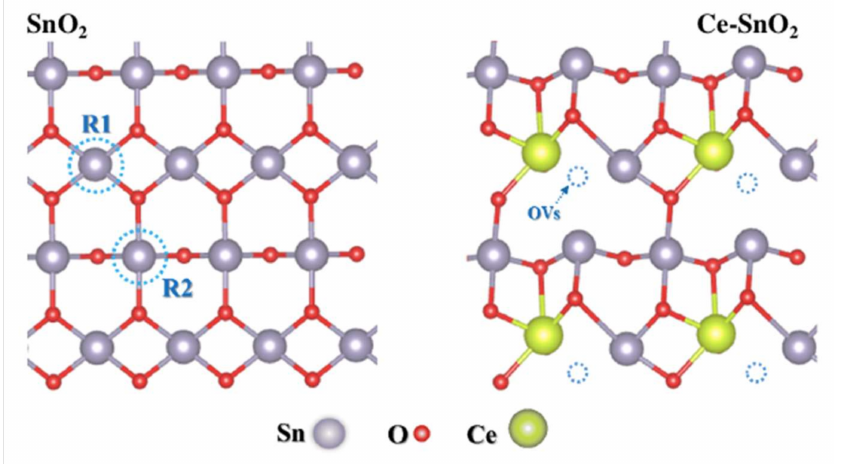
Figure 7. Crystal structure of SnO 2 and optimized structures of Ce-SnO 2 . (R1, R2) represent different replace positions. The Ce atom easily replaces the Sn atom in the R1 position and the O atom connected to the Ce atom is easily lost. Reproduced with permission from Ref. [84].